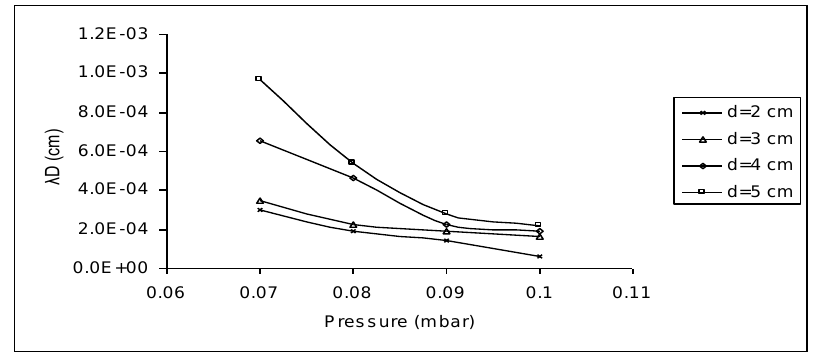
Fig.7: Debye length with plasma pressure at different electrode